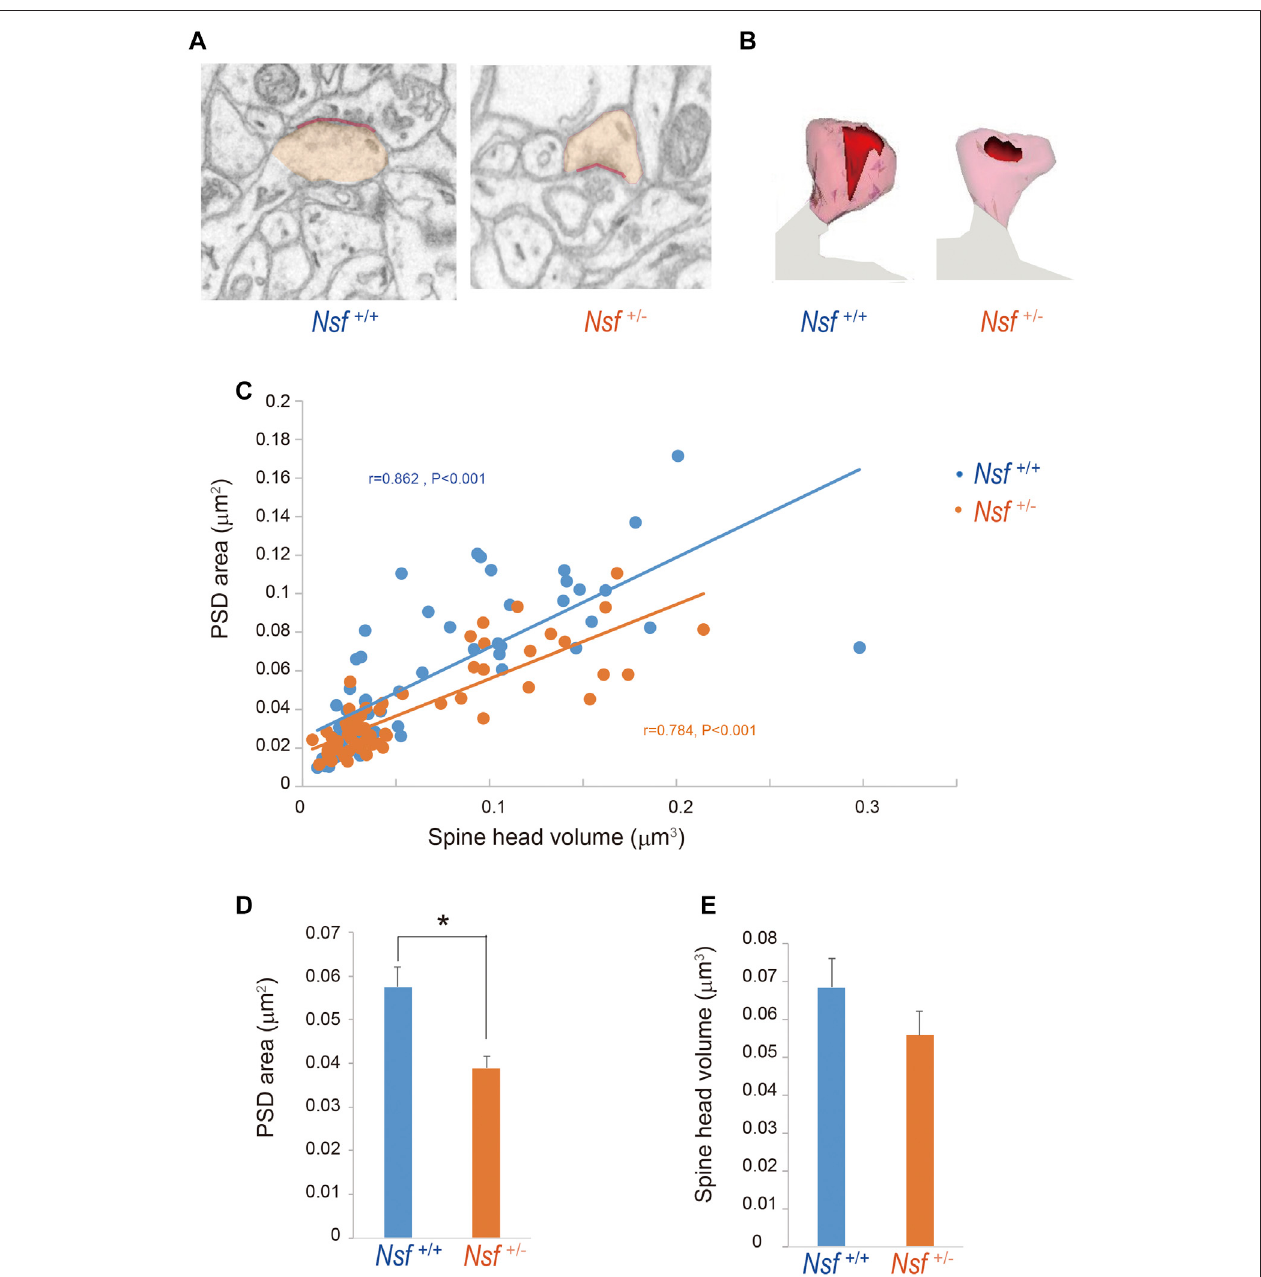
FIGURE7| Decreaseinpostsynapticdensity(PSD)areainpostsynapticmembranein Nsf +/ − mice.ReconstructionofdendriticspinesfromserialFIB-SEMimages. PSDwasde fi nedaspostsynapticmembranespecialization. (A) RepresentativeFIB-SEMimagesofthehippocampalCA1regionof Nsf +/+ and Nsf +/ − mice(spineheadin orange andPSDinred). (B) Examplesof3D-reconstructedspinesfrom Nsf +/+ and Nsf +/ − mice(headintransparent orangeand PSDinred). (C) Correlationbetweenthe PSD area and spine head volume in mice of each genotype (Spearman ’ s rank-order test: Nsf +/+ mice, n (cid:1) 58 synapses, r (cid:1) 0.862, p < 0.001; Nsf +/ − mice, n (cid:1) 65 synapses, r (cid:1) 0.784, p < 0.001). (D) TheaveragePSD areas and (E) head volumes inthe hippocampusof Nsf +/+ and Nsf +/ − mice (mean ± SEM. Spearman ’ srank-order test, p (cid:1)